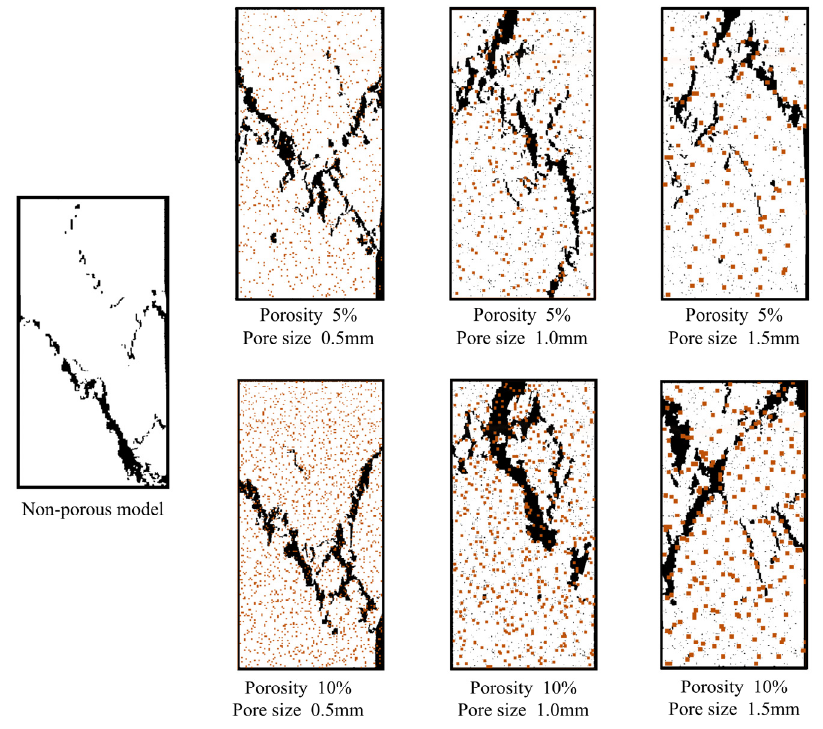
Figure 12. Distribution of fractures after crushing under different pore characteristics.